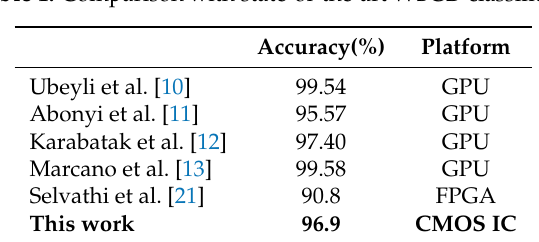
Table 1. Comparison with state-of-the-art WBCD